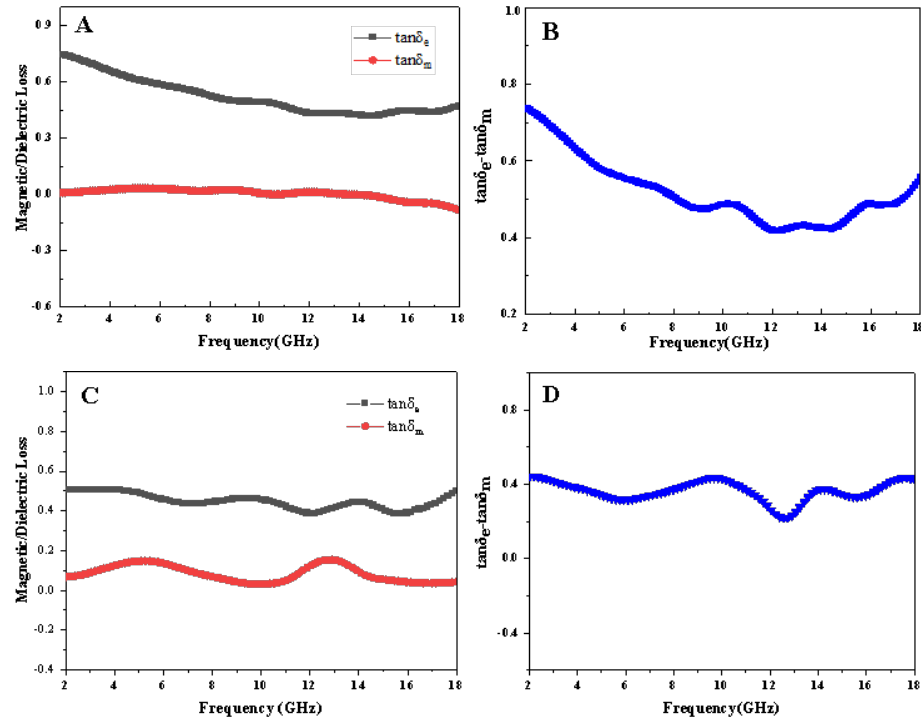
Figure 9. The relationship curve between the loss tangent and the difference between the loss tan- gent and the frequency of the magnetic composite microspheres: Fe@C-12 ( A,B ) and Fe 3 O 4 @C-700 ( C,D